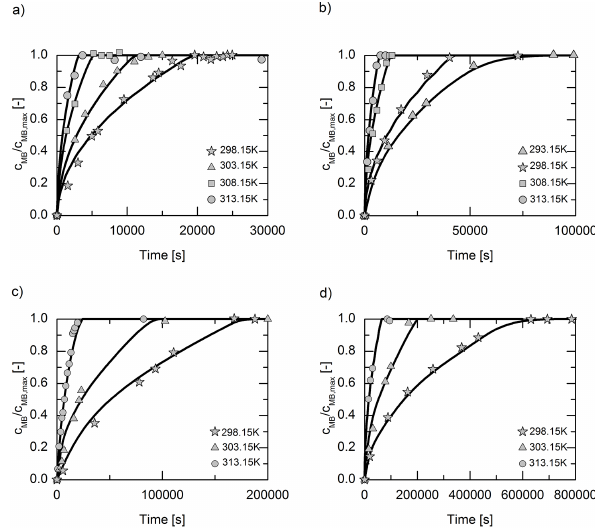
Figure 4. MB concentration profiles in PVA films of 170µm thick- ness at temperatures between 293.15 and 313.15 K. The water mass fractions are 0.170 (a) , 0.133 (b) , 0.110 (c) and 0.089 (d) . Sym- bols are experimental data and lines are modeled profiles using oxy- gen diffusion coefficients in the PVA film from Table